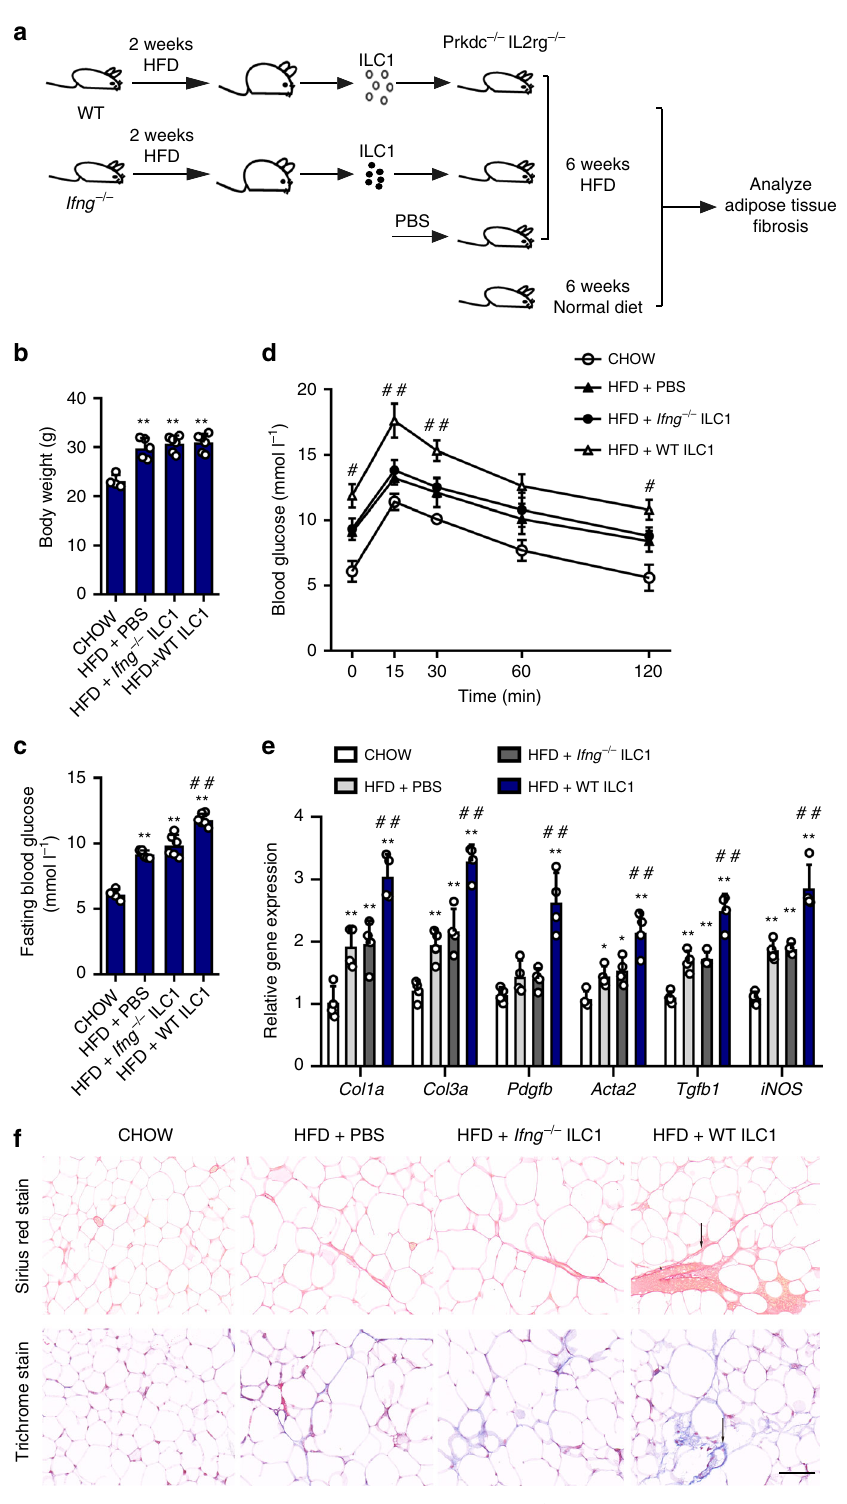
Fig. 5 Adipose ILC1s induce adipose fi brosis through IFN- γ production. C57BL/6 and Ifng − / − mice were fed a HFD for 2 weeks, and 5 × 10 4 adipose ILC1s were sorted (>95% purity) from adipose tissue of each group and adoptively transferred i.v. into separate Prkdc − / − IL2rg − / − mice. The recipient mice were fed a HFD for 6 weeks. Three weeks after HFD, adipose ILC1s were adoptively transferred into recipients again. a Schematic of the experiment. b Body weight. c Fasting blood glucose. d Glucose tolerance test. e Expression levels of fi brosis-related genes, assessed by q-PCR. f Representative Masson ’ s trichrome C and Sirius red staining in VAT of mice with different treatment (scale bar: 100 μ m). Arrows indicate positive staining areas. * P < 0.05 vs. CHOW group; ** P < 0.01 vs. CHOW group; # P < 0.05 vs. HFD + Ifng − / − ILC1 group; ## P < 0.01 vs. HFD + Ifng − / − ILC1 group (two-way ANOVA tests followed by Bonferroni post hoc test). The data are representative of two independent experiments, with n = 4 – 6 mice per group. Error bars indicate